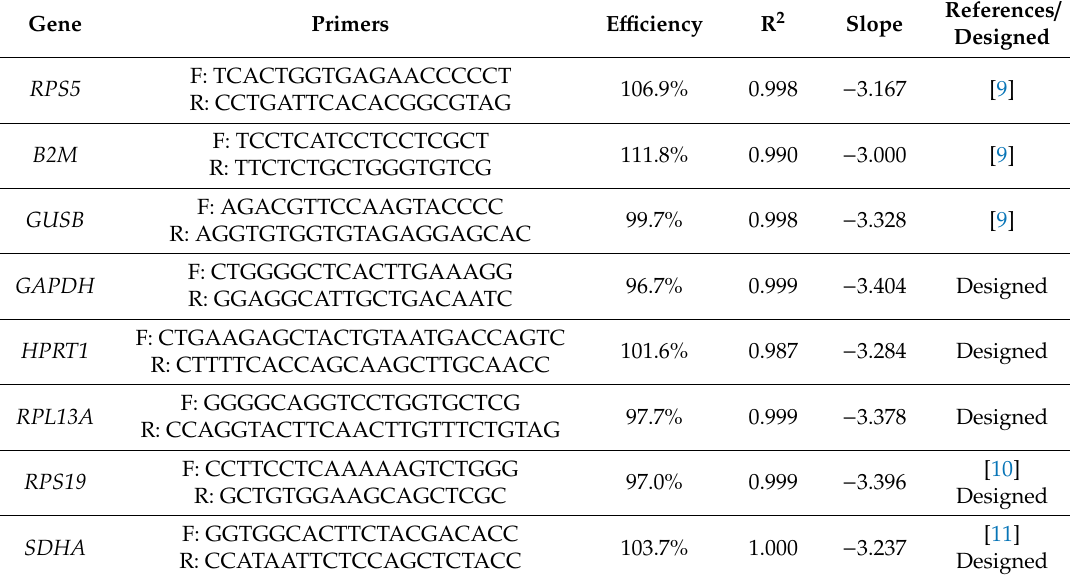
Table 1. Characteristics of the primers used and the bibliographic